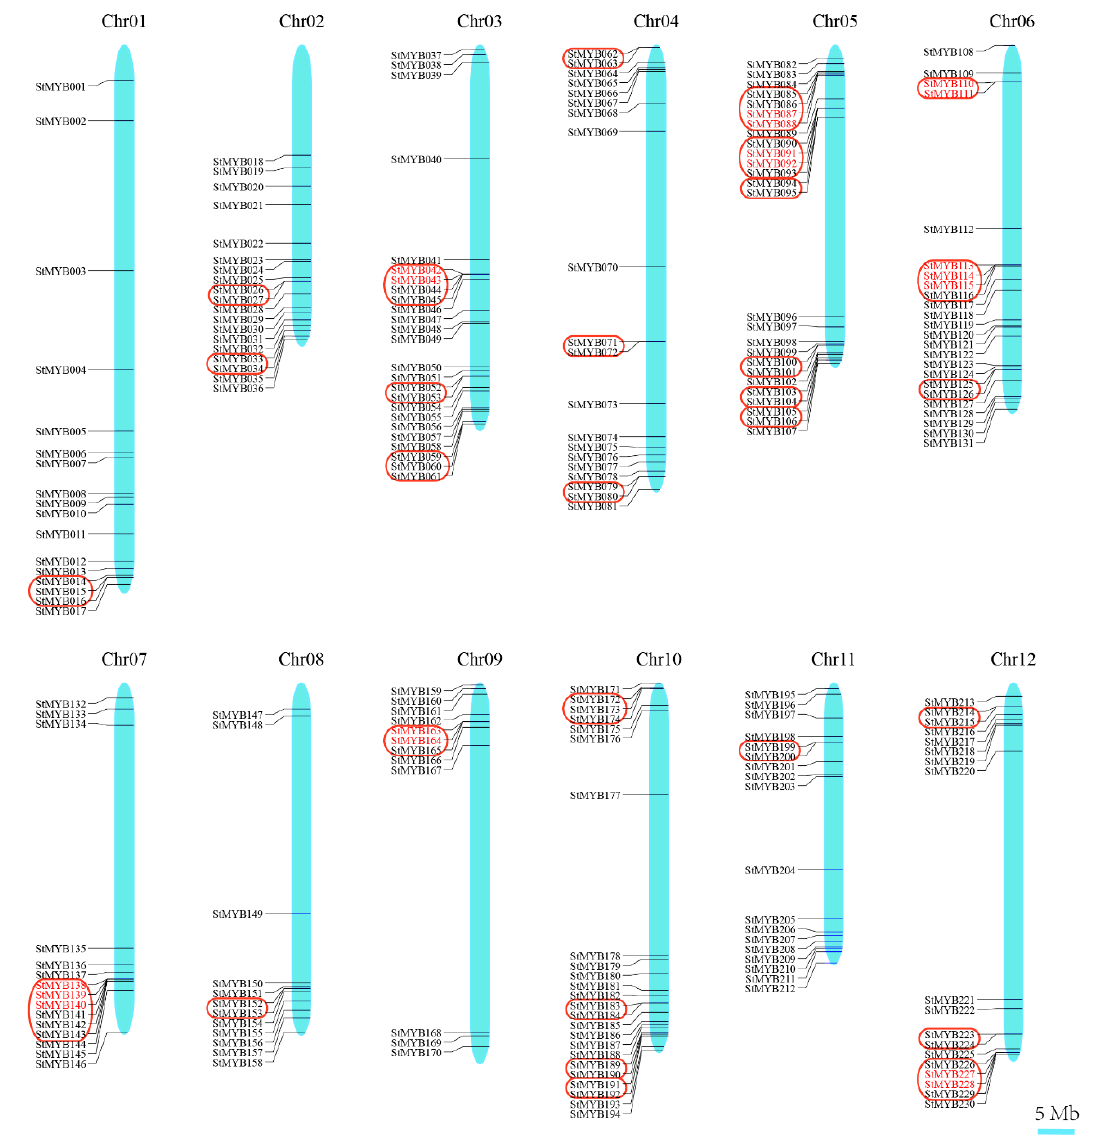
Figure 4. Distribution of StMYB genes on potato chromosomes. In potato, 230 StMYB genes were successfully mapped to 12 potato chromosomes. The red box indicated the gene cluster, while the tandem duplication pair was featured by red color.